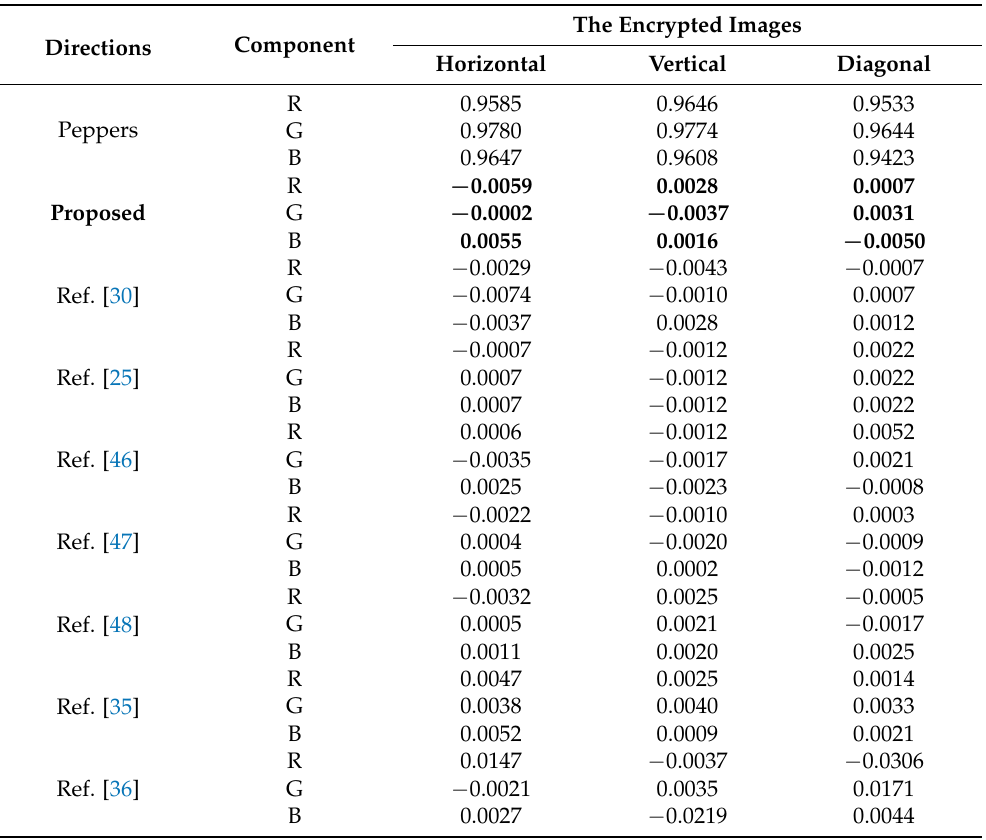
Table 11. Correlation coefficients of Peppers (The bold part is the relevant values of the proposed